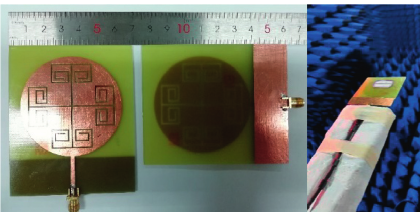
Figure 12: Fabricated antenna prototype and experimental test setup in an anechoic chamber.